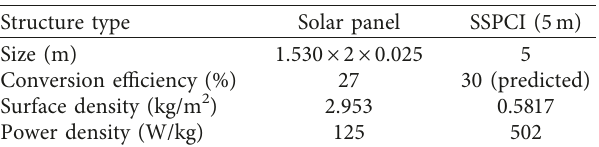
Figure 31: Three moments of the sun tracking process of the TER pointing mechanism on the ground: (a) morning moment; (b) noon moment; (c) afternoon moment. (d) The shadow region on the mounting sleeve. Table 5: Predicted comparison between the SSPCI and the solar